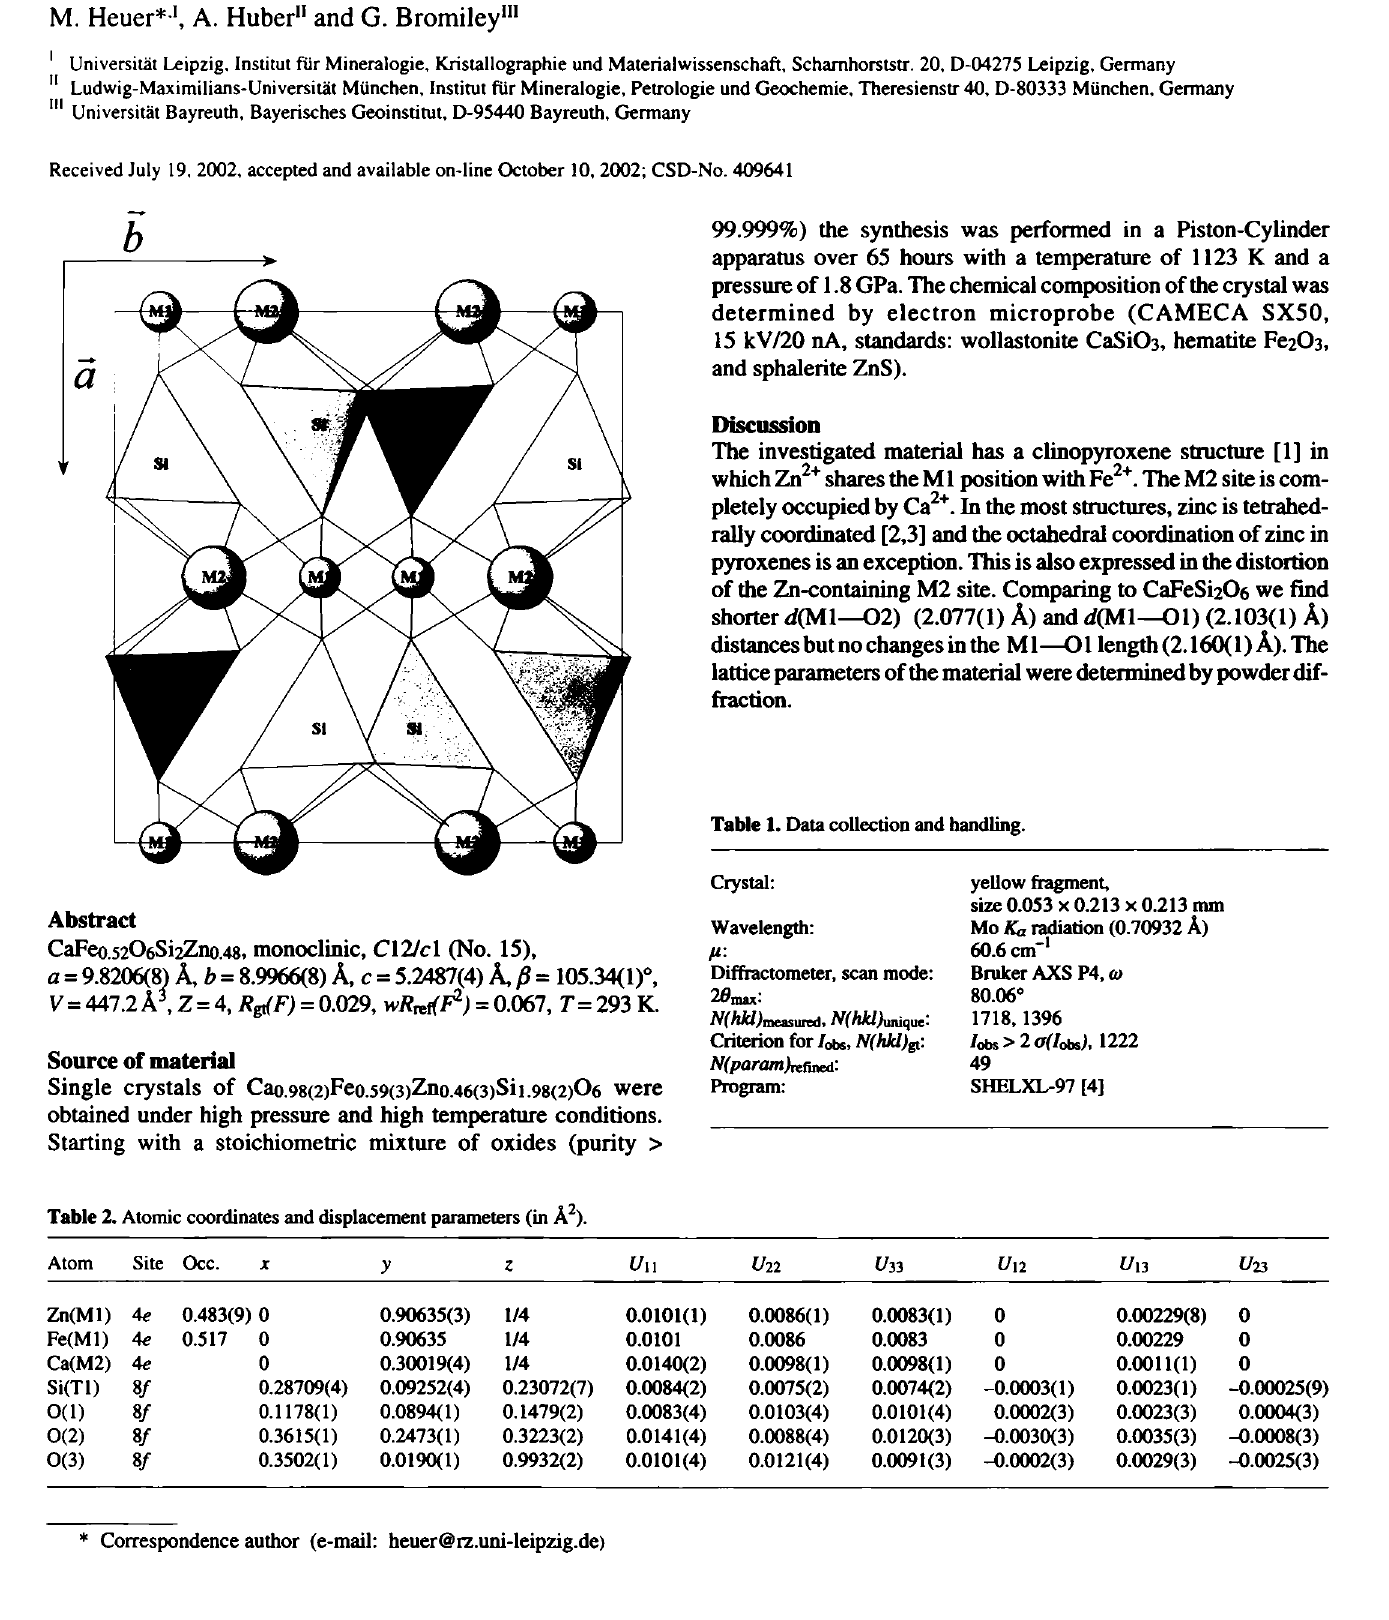
Table 2. Atomic coordinates and displacement parameters (in Â 2